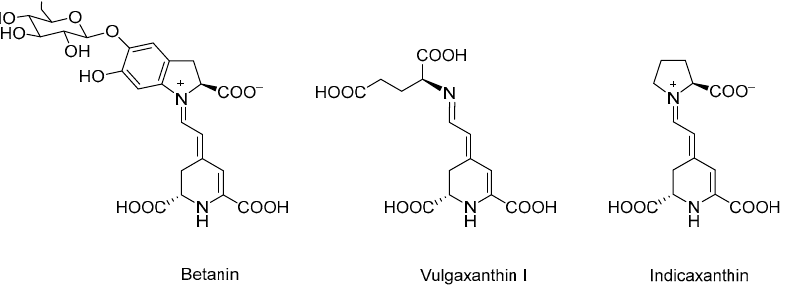
Figure 1. Chemical structures of betanin (BET), vulgaxanthin I (VUL) and indicaxanthin (IND).